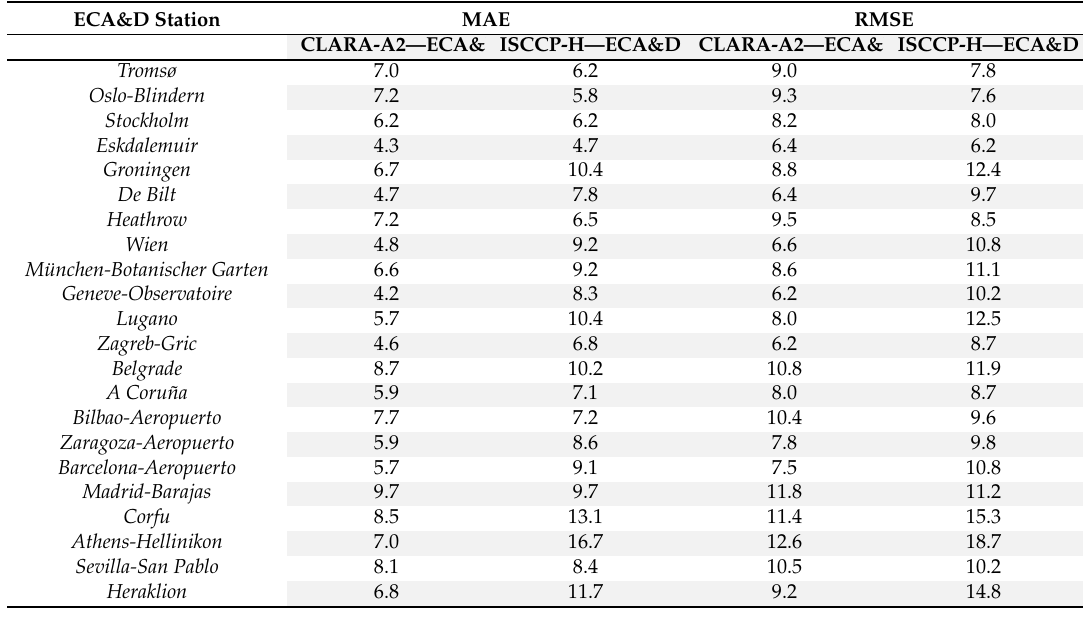
Table 4. Mean Absolute Error (MAE) and Root Mean Squared Error (RMSE), both in percent cloud cover, for the comparison between CLARA-A2 and ISCCP-H against ECA&D stations.